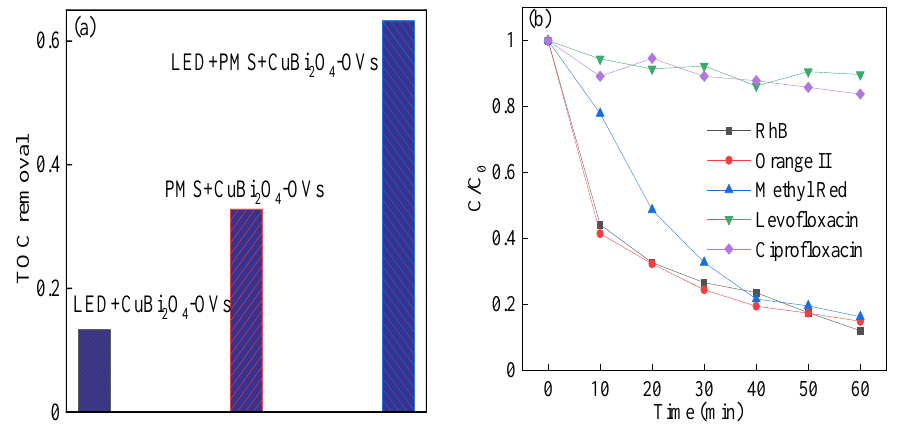
Figure 8. ( a ) Total organic carbon (TOC) removal of RhB; ( b ) degradation of various contaminants in heterogeneous SR-photo-Fenton like reaction. Reaction conditions: contaminants (20 mg/L), PMS (0.4 mM), catalyst (0.5 g/L), neutral pH.